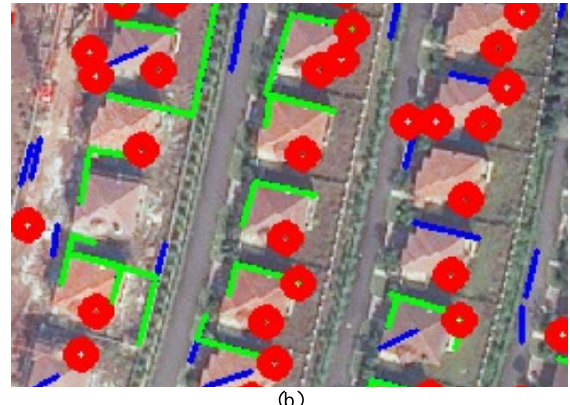
Fig.2 (a) the test image , (b) geometric features of artificial areas in local artificial areas